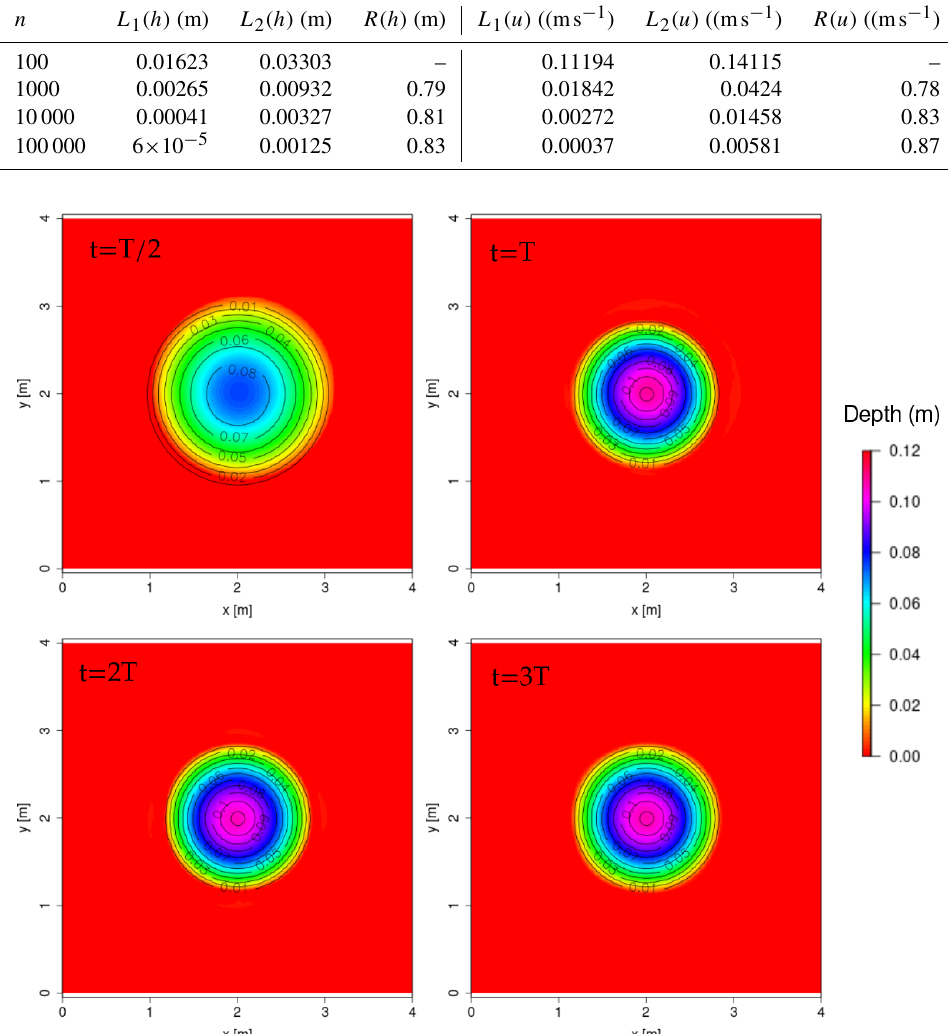
Figure A6. Radially symmetrical paraboloid: snapshots of water depth by the model compared to the analytical solution (contour lines). Period T =